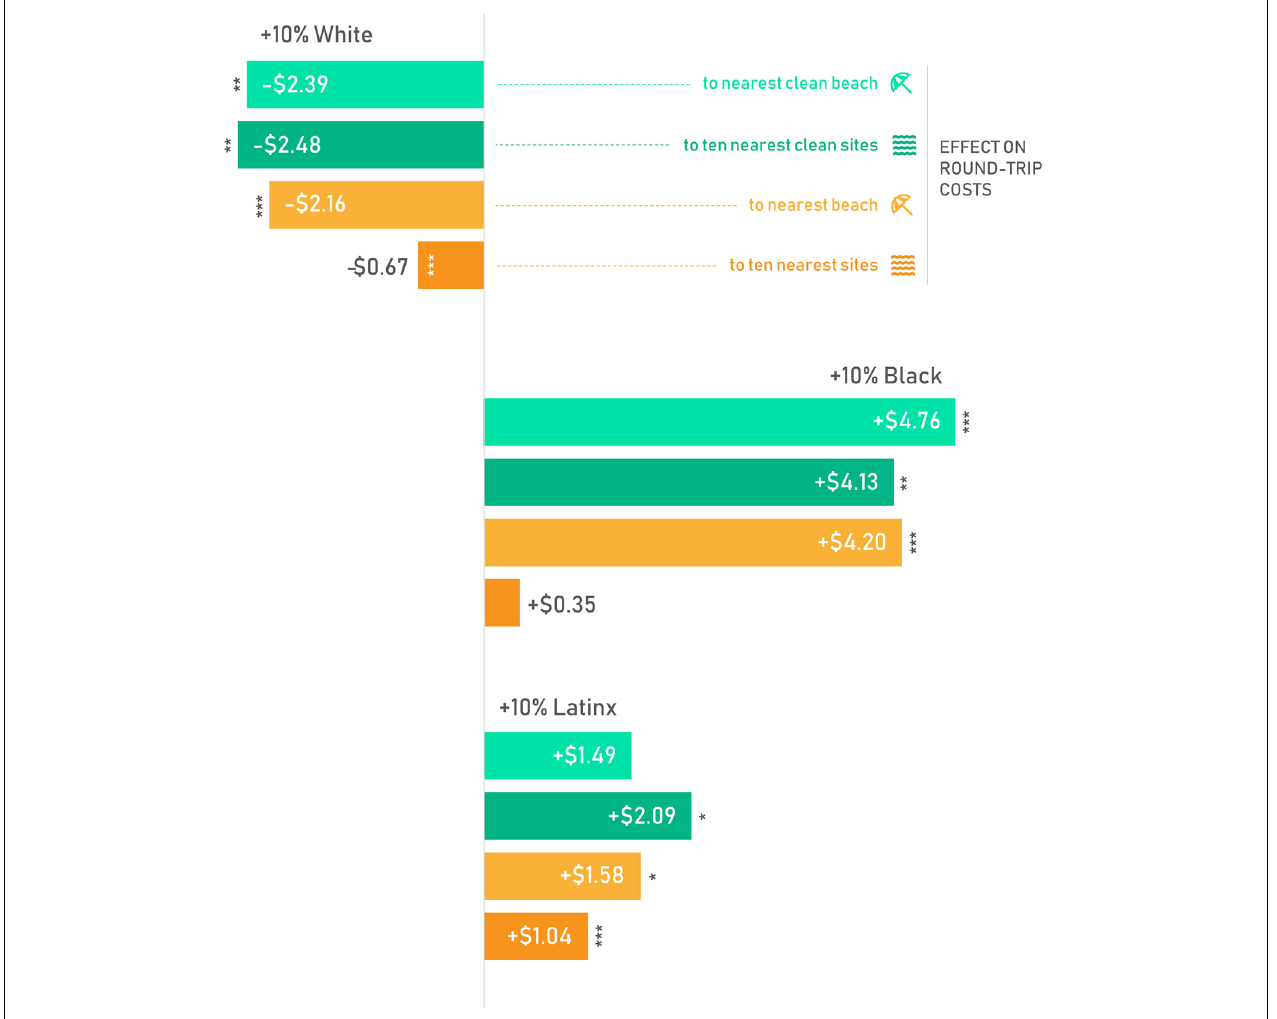
FIGURE 3 | Change in round-trip travel cost by race and/or ethnicity to public access points and public beaches. Differences in travel costs are calculated from travel distance coefficients. These can be interpreted as change in cost for travel from any block group that would be associated with a ten percent increase in the white, Black, or Latinx population. Stars indicate the level of significance for the change in travel distances, from regressions in Tables 4 , 5 (* p < 0.05; ** p < 0.01; *** p < 0.001). Travel costs in USD($) are based on the 2016 IRS mileage reimbursement rate of 33.2cents/km, a mean vehicle speed of 35km/h, the 2016 median income for RI of $60,201 ($28.99/h), and the coefficient from regression 5 for the race/ethnicity group multiplied by two. Parking/fees not